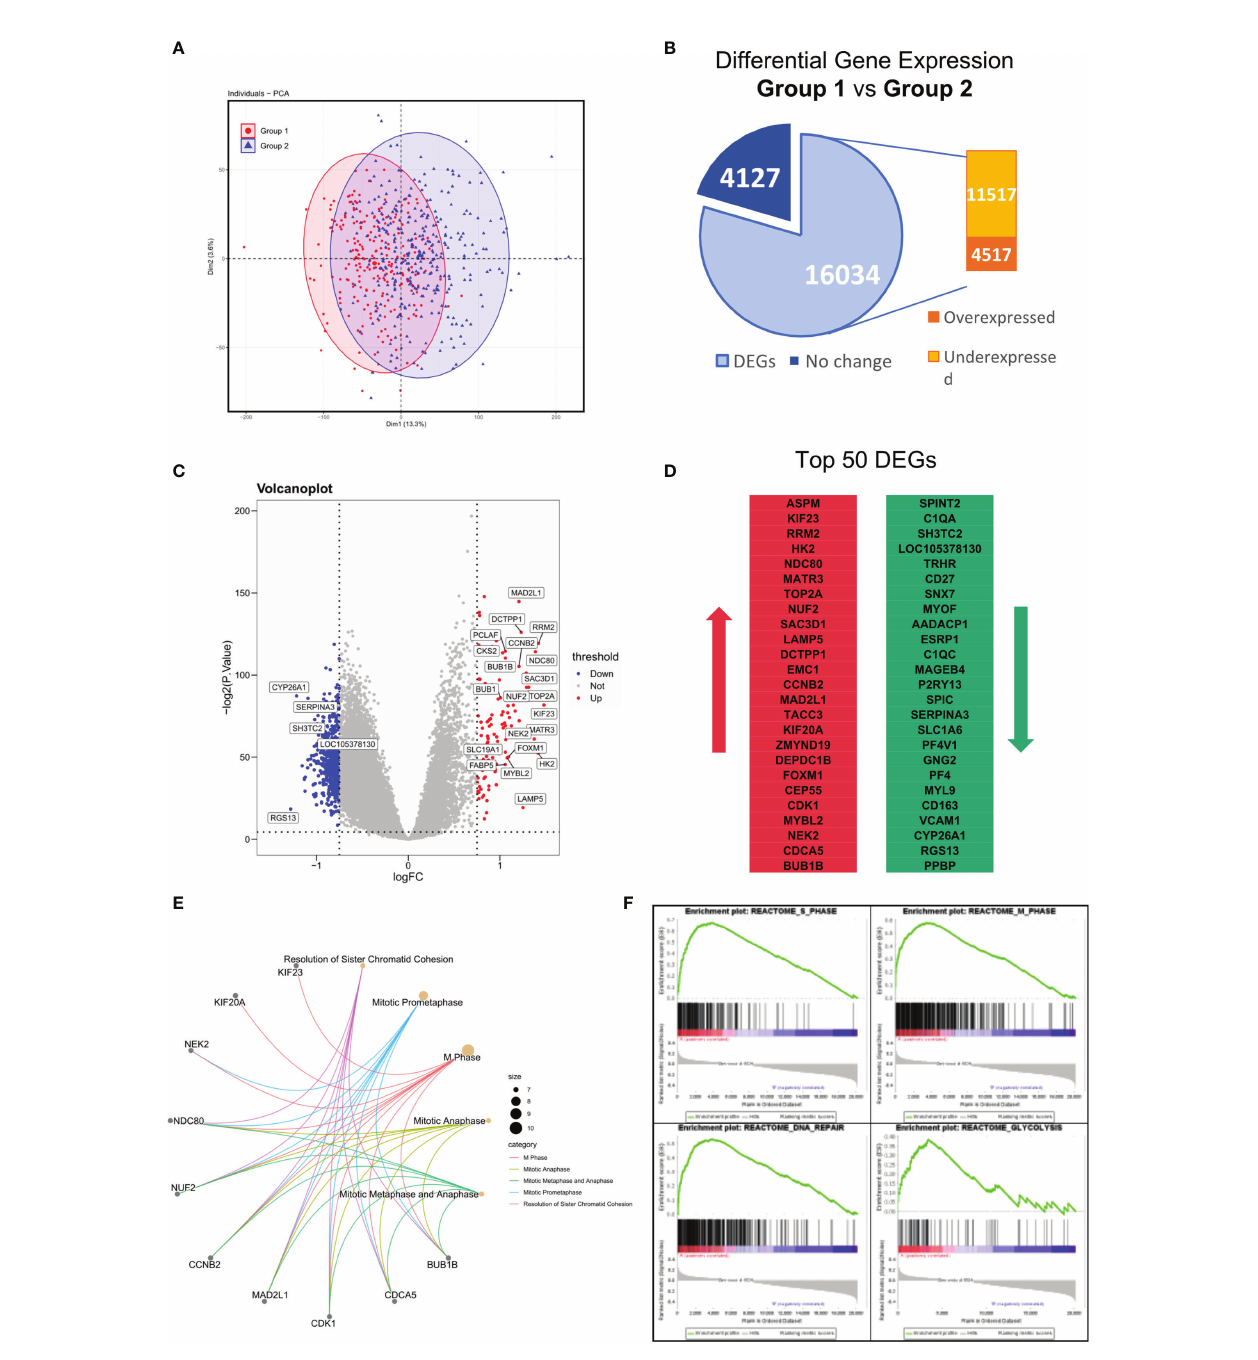
FIGURE 6 | Differentially expressed genes (DEG) between Group 1 and Group 2 in GSE24080. (A) Principal components analysis of transcriptome data of group 1/2 MM patients from the GSE24080 dataset. (B) Differential gene expressions of group 1 relative to group 2 MM samples. Genes with positive log2 FC and p < 0.05 were considered overexpressed, and genes with negative log2 FC and p < 0.05 were considered underexpressed. (C) Volcano plots of DEGs. Red/Blue plots represent genes with |log2 FC| > 1 and p < 0.05. (D) List of the 50 most deregulated genes: the 25 most overexpressed and the 25 most underexpressed genes in group 1 relative to group 2 MM samples. (E) The top 5 reactome pathways enriched in the top 50 DEGs between groups 1 and 2. (F) The GSEA analysis of reactome pathways upregulated in group 1 MM